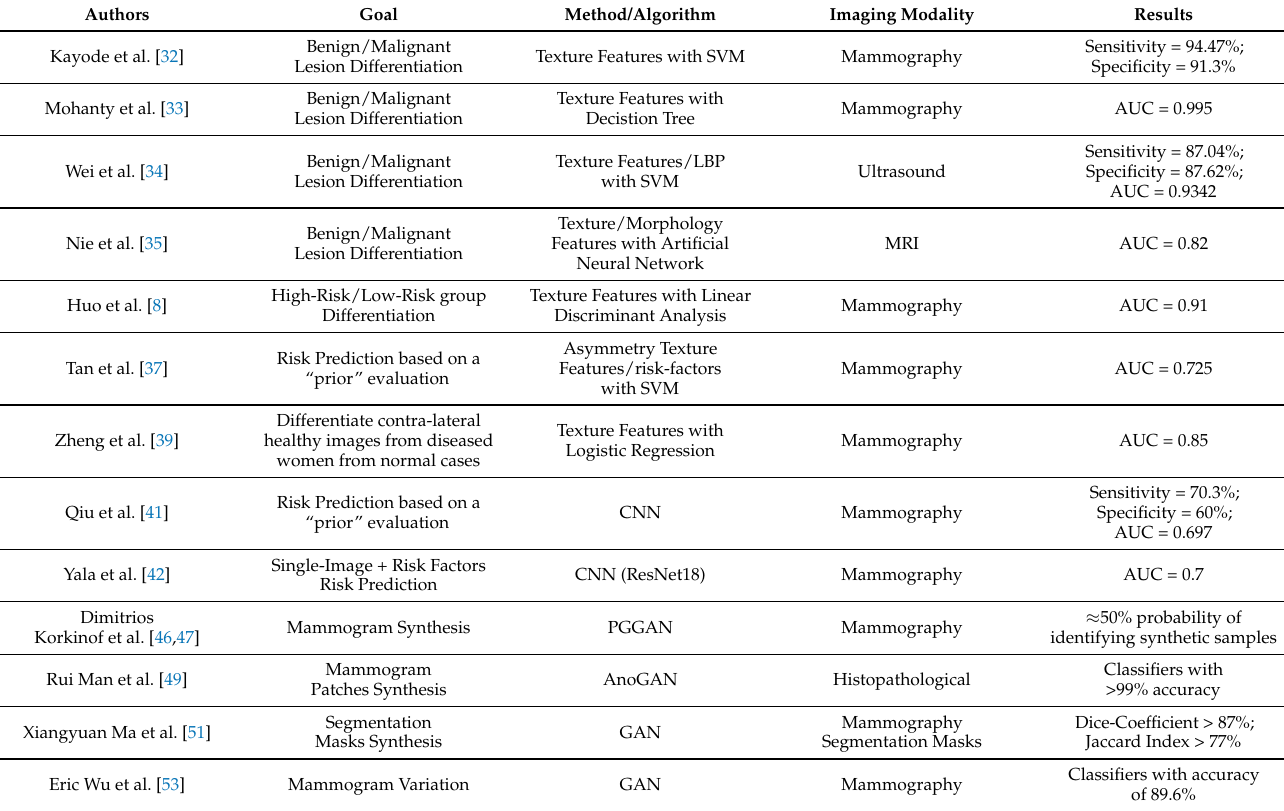
Table 1. Studies